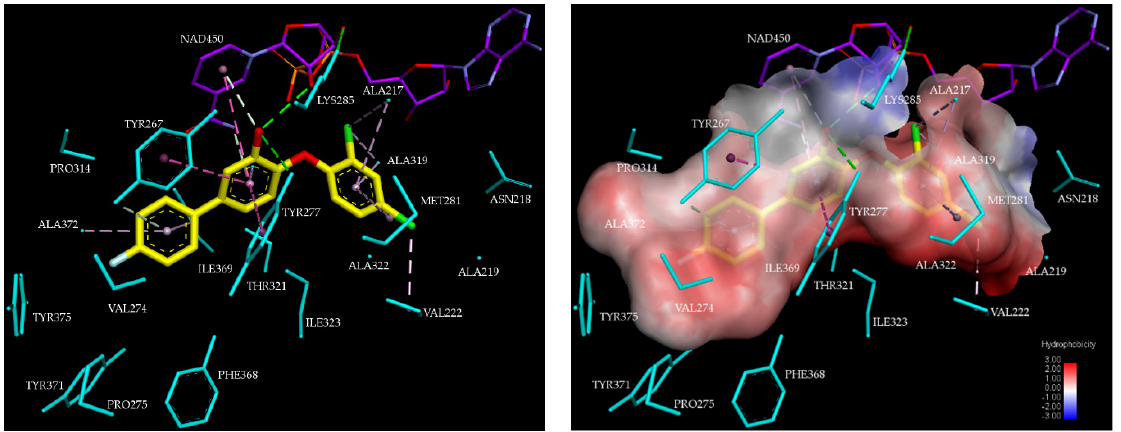
Figure 3. 2D scheme of interactions of the most potent Pf ENR inhibitor TCL15 ( IC (cid:2873)(cid:2868)(cid:2915)(cid:2934)(cid:2926) (cid:3404) 38 nM, [9,17]) with the residues of the reductase active site.